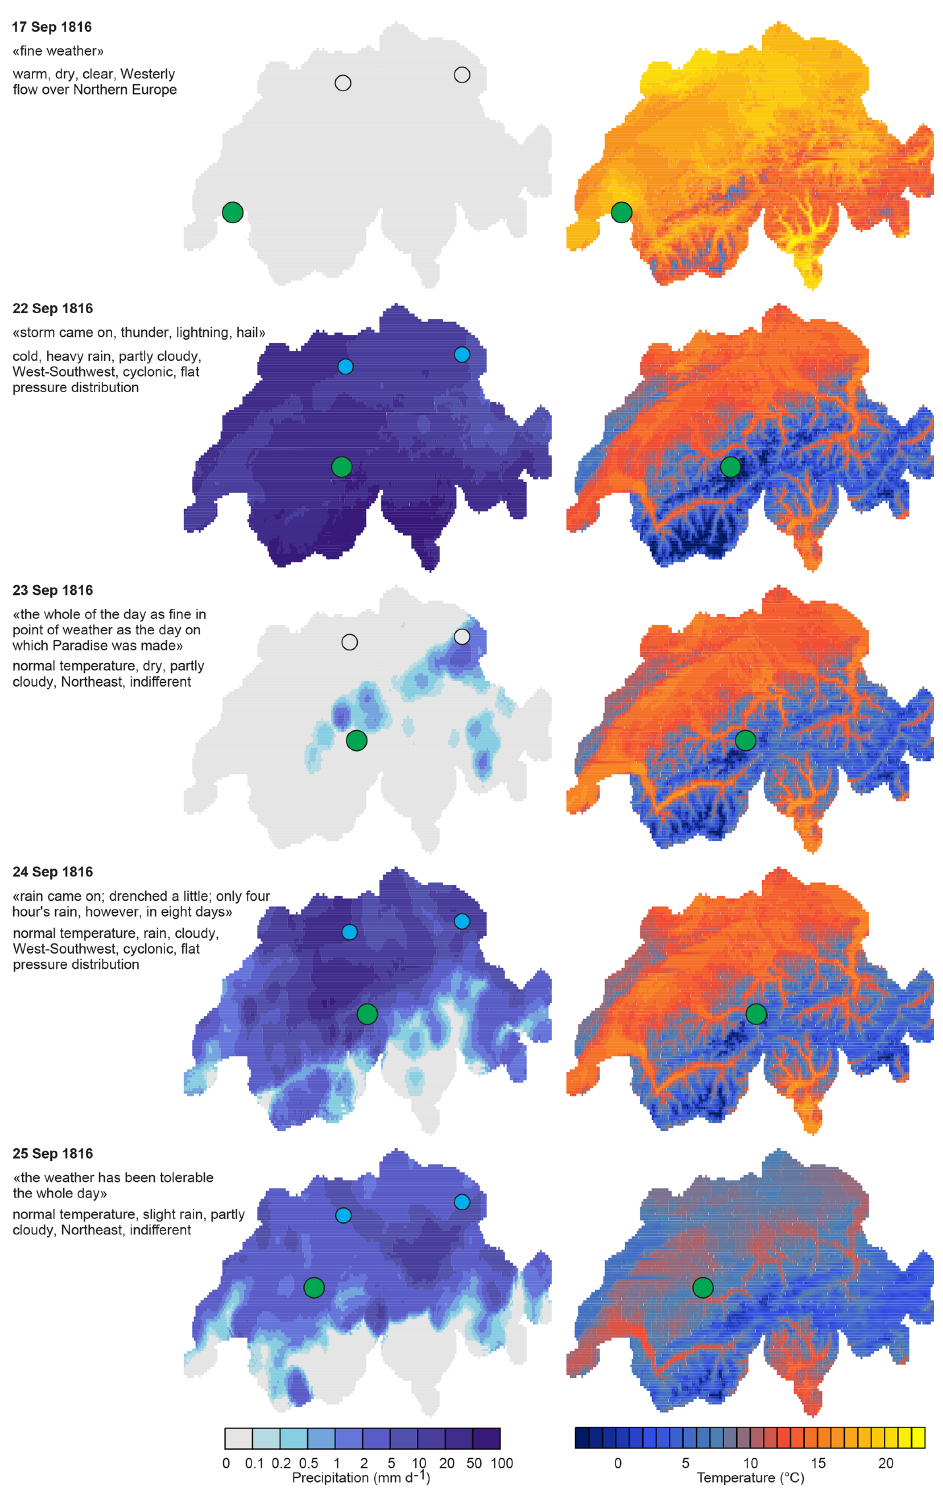
Figure 3. The weather during Lord Byron’s travel from Lake Geneva to the Bernese Oberland in September 1816. The figure shows his diary entries (in quotation marks) as well as the synthetic weather diary for 5d. Also shown are precipitation and daily mean temperature from the reconstructions. The green dot marks the position of Lord Byron. The small dots indicate whether the observers at Aarau and St. Gall noted precipitation (blue) or not